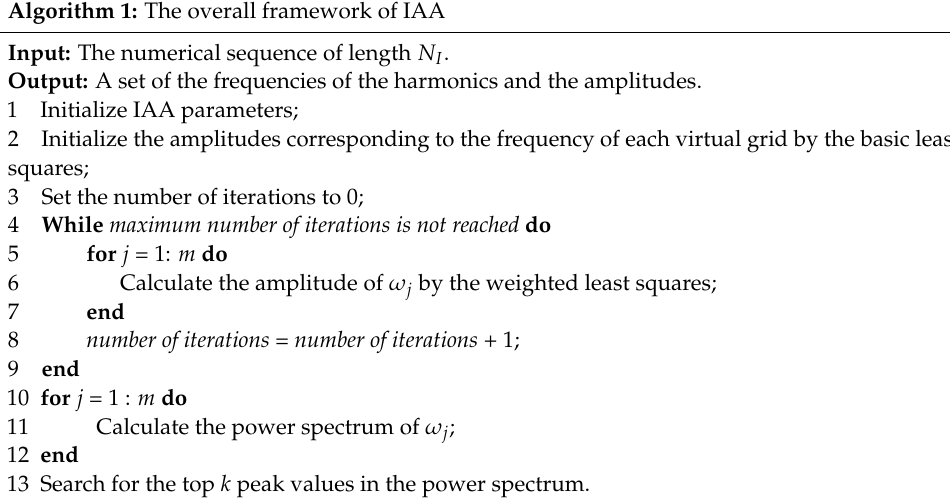
Algorithm 1: The overall framework of